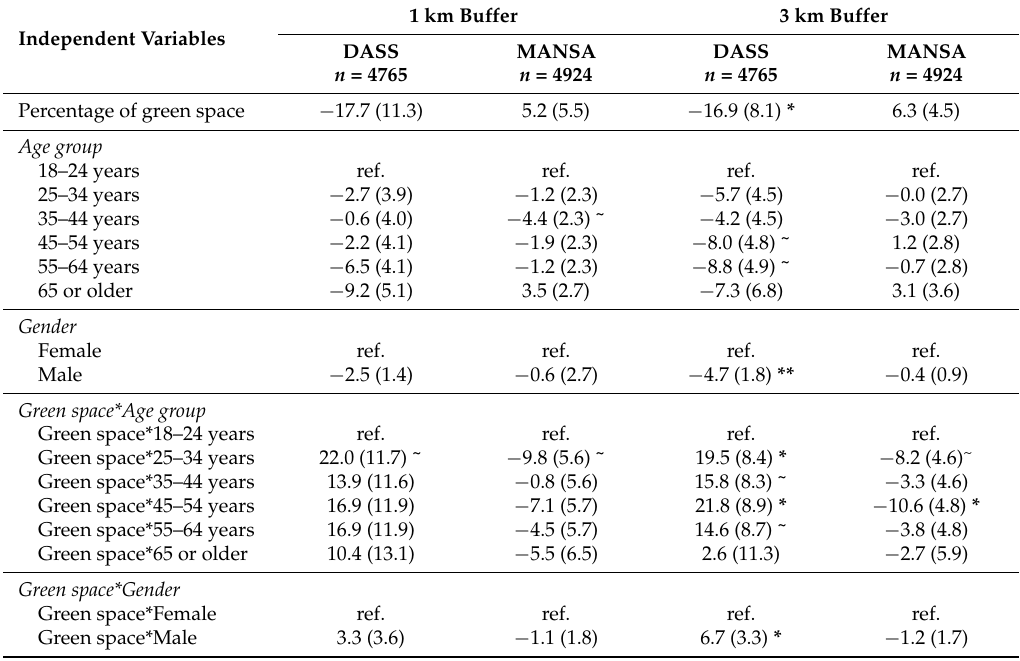
Table 2. Regression analyses for the association between green space and mental health, moderated by age and gender.